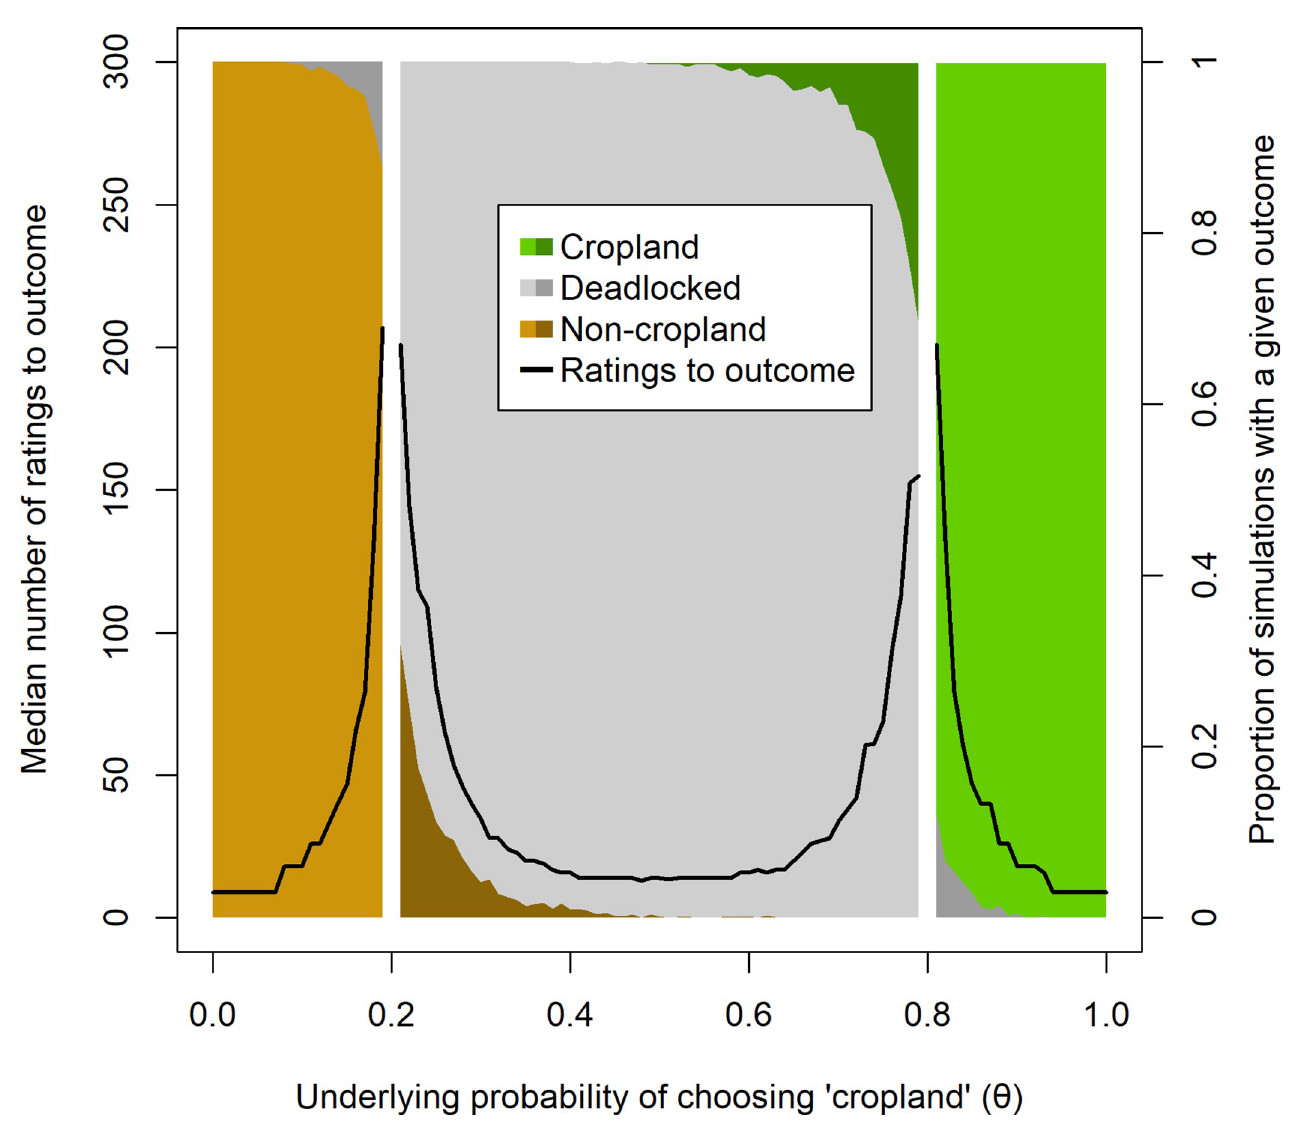
Fig 6. Simulated classification outcomes as a function of underlying probability of choosing a cropland rating. Colored regions represent each of the three outcome categories (cropland, deadlocked, non-cropland) and black lines the median number of ratings to reach these outcomes. The lighter colors indicate correct conclusions and the darker colors incorrect conclusions. Note that the simulations were not performed for values of θ = .2 or .8 (see main text), hence the breaks in the figure at these values.